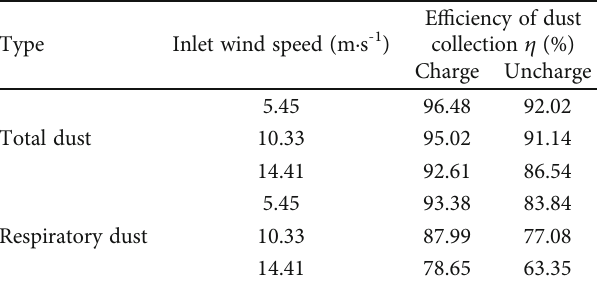
Figure 15: E ffi ciency curve of fractional dust removal by the new type of electrostatic precipitator. Table 4: Charged water mist and uncharged water mist in fl uence on dust removal e ffi